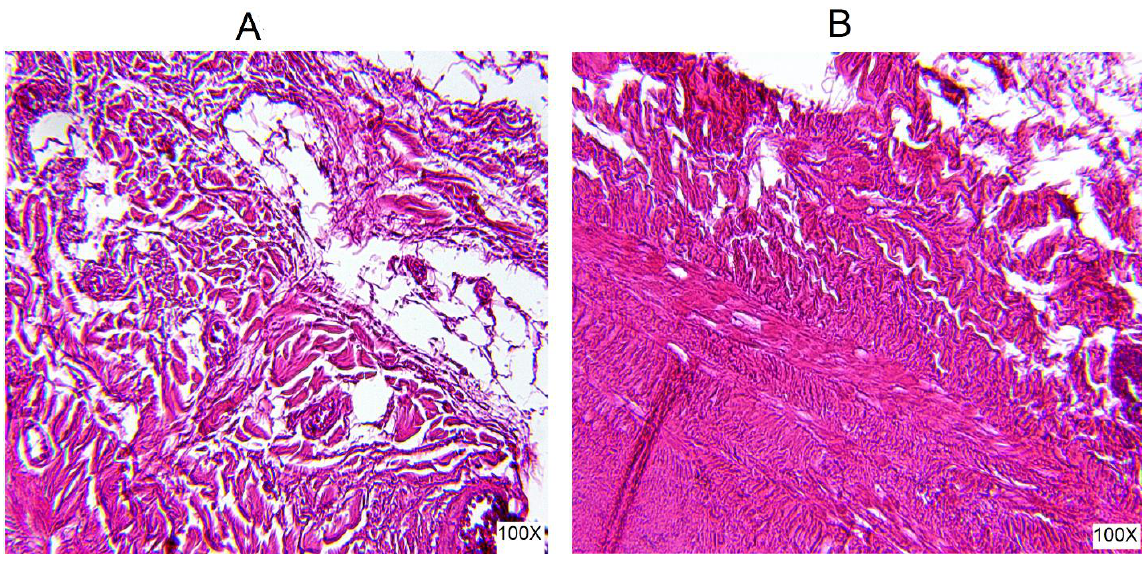
Figure 4: hematoxylin and eosin staining pathology for aortic aneurysm confirmation, Case1, A and Case 2, B: medial layer